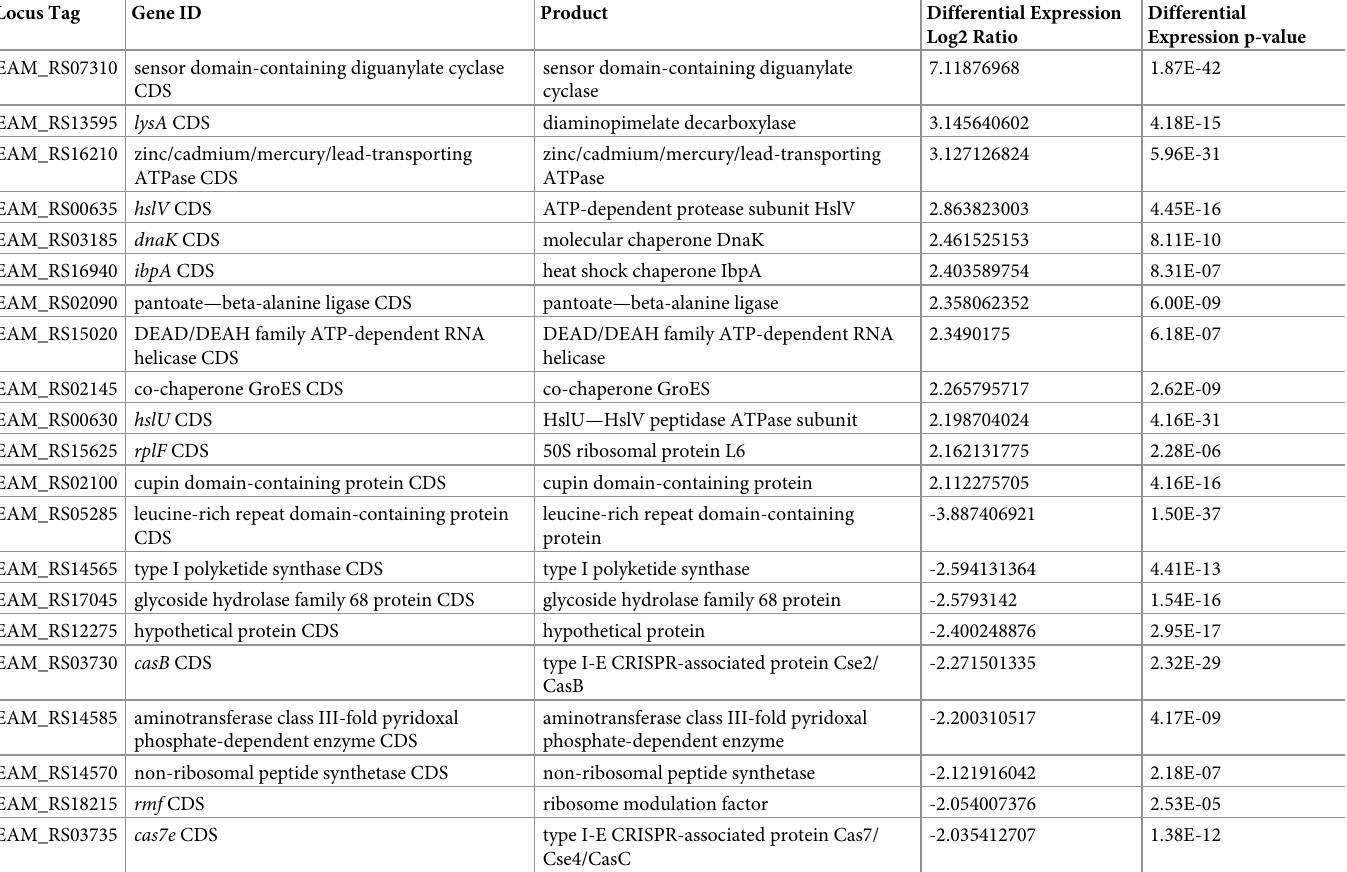
Table 5. A list of the statistically significant differentially regulated genes (Log2 fold change of two) in Ea1189 Δ 8+ edcC OE relative to Ea1189 Δ 8. Locus Tag